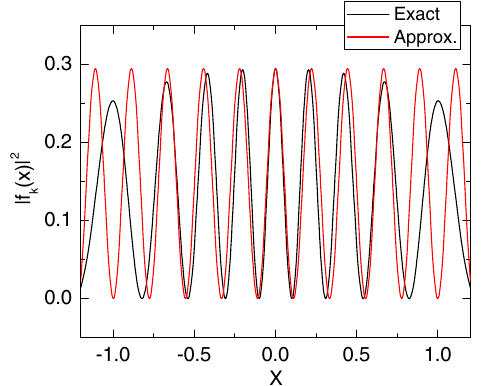
FIG. 2. Comparison of j f k ð X Þj 2 computed with the exact (15) and approximate (22) formulas when K ¼ 2 . 2 and k ¼ 11